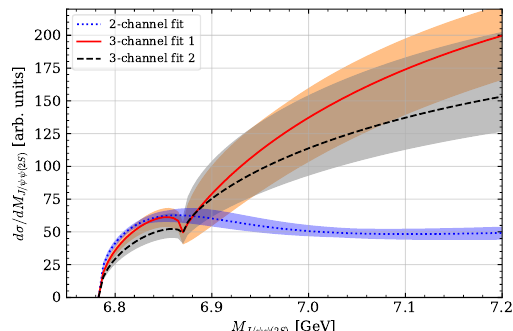
Figure 4: Predictions for the invariant mass spectrum in the ψ ( 2 S ) J /ψ final state. Adapted from Ref. [ 2 ] under arXiv.org non-exclusive license to distribute. Table 1: Fitted parameters of the 2-channel model ( [ ¯ a [ ¯ c ]= GeV − 2 ) and χ 2 / dof.